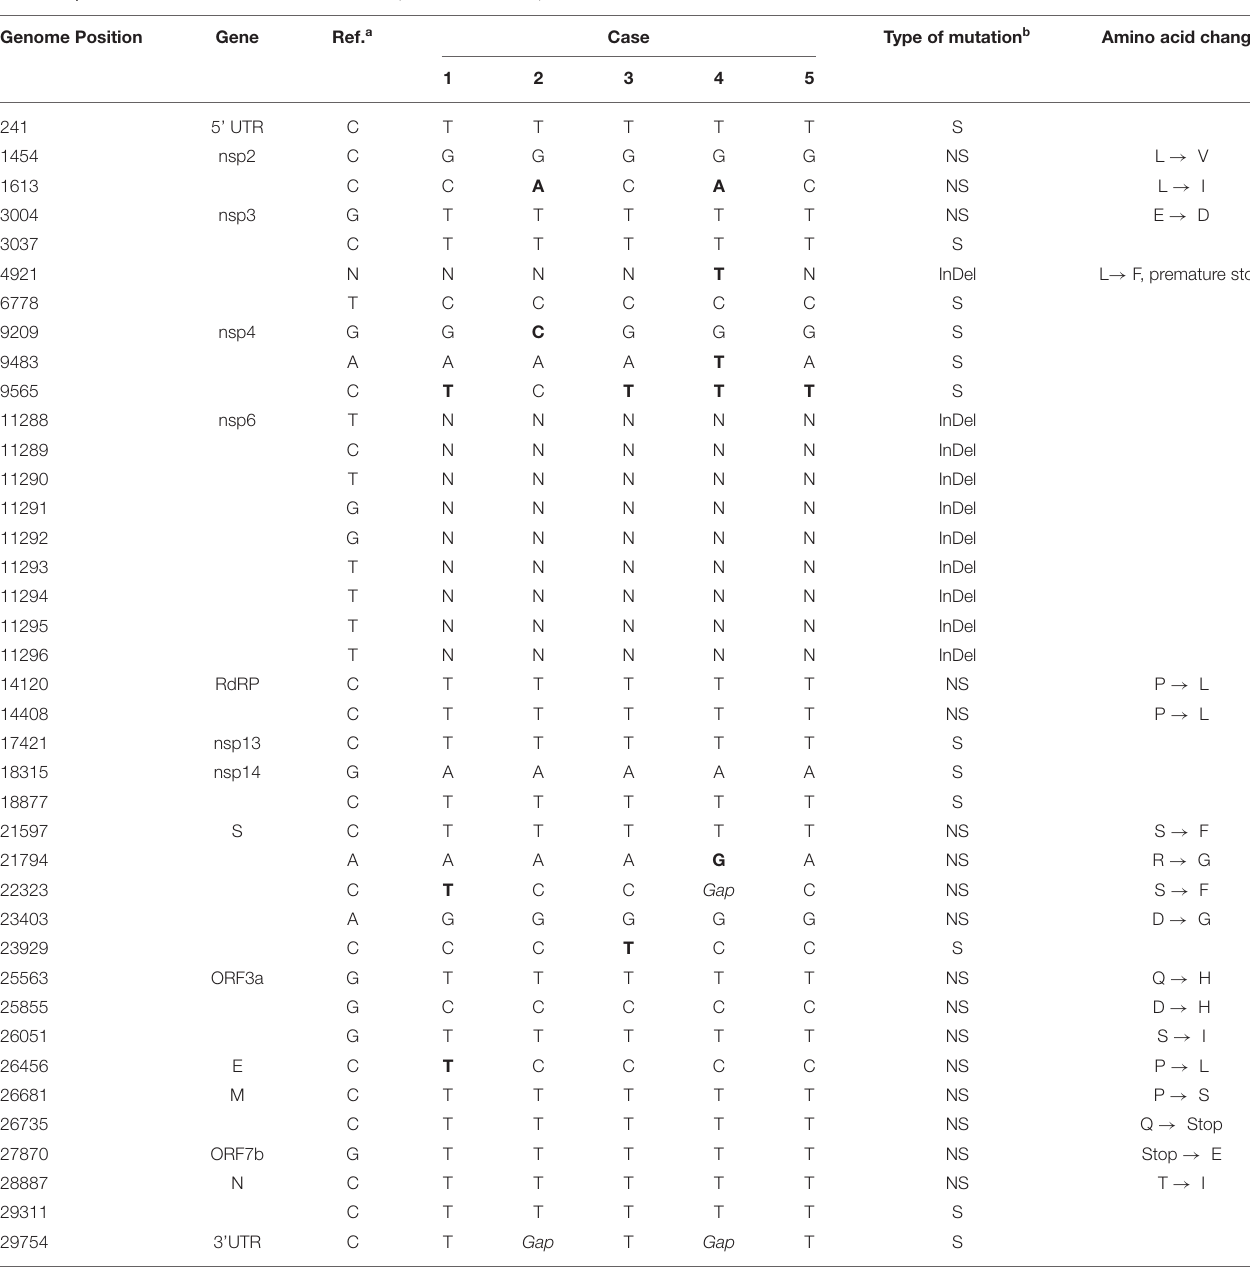
TABLE 2 | List of mutations based on consensus sequences of the five pediatric cases. Genome Position Gene Ref. a Case Type of mutation